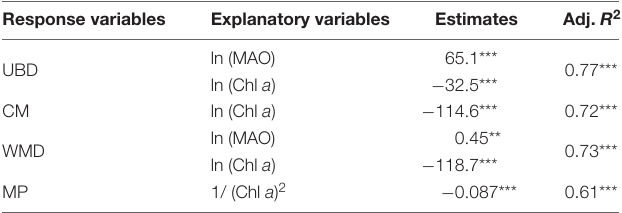
TABLE 2 | Details of models, and variables used in